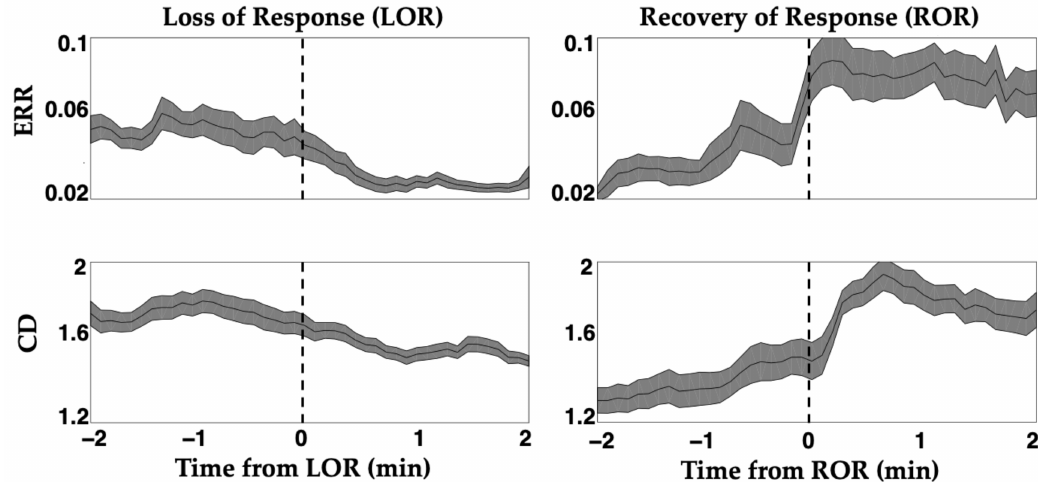
Figure 8. Attractor measures exhibit differing dynamics around loss and recovery of response. Induction of anesthesia and emergence from anesthesia produces an asymmetrical dynamic, known as hysteresis. Complexity measures, both the ellipse radius ratio (ERR) and the correlation dimension (CD), track these different dynamics at loss of response (LOR) and recovery of response (ROR). LOR and ROR timepoint areas are indicated with dashed lines. Dynamics are more gradual during LOR and more abrupt during ROR. Differences in dynamics observed here support existing paradigms that these brain state transitions are unique. Solid black lines represent the mean complexity values at each time point for all patients, and the shaded area is the standard error of the mean. Adapted with permission from Reference